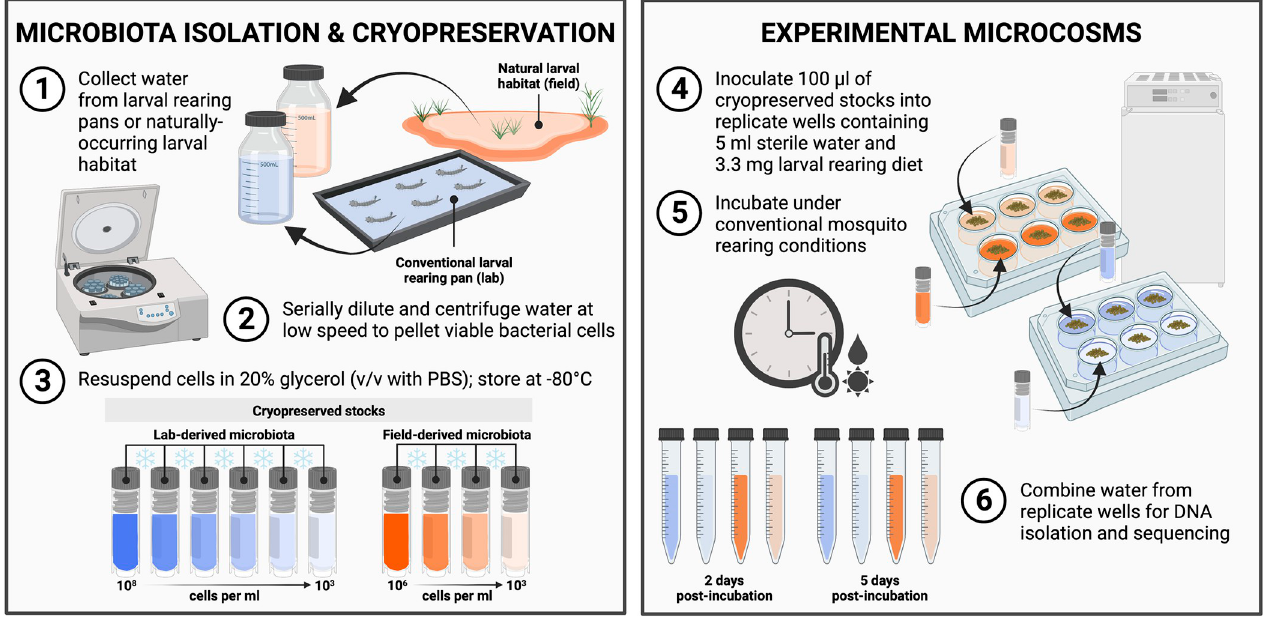
Fig 1. Overview of methodology used to isolate and cryopreserve microbiota and generate experimental microcosms. ( Left ) Isolation and cryopreservation of microbiota from conventional larval rearing pans of our laboratory colony of Ae . aegypti mosquitoes or a naturally occurring larval habitat in the field. Water from four replicate rearing pans containing larvae that had molted to the final (fourth) instar was collected from the lab, while four aliquots of water from the same larval habitat were collected from the field [1] prior to serial dilution and centrifugation at low speed to pellet any viable bacterial cells [2]. The resulting cell pellets were then resuspended in 20% glycerol (v/v with PBS) and stored at -80˚C to produce a total of 40 cryopreserved stocks at variable cell densities (~10 3 − 10 8 bacterial cells per ml) for use in downstream experiments [3]. Aliquots of non-cryopreserved fresh water from each rearing pan or habitat water sample in [1] were also immediately centrifuged at high speed prior to removal of any supernatant and storage of pellets at -20˚C for downstream DNA isolation and sequencing to characterize microbiota diversity. ( Right ) Generation of experimental microcosms colonized by standardized bacterial communities. Aliquots of 100 ul from each cryopreserved stock were inoculated into replicate wells of 6-well culture plates containing 5 ml of sterile water and 3.3 mg of a standard larval diet sterilized by gamma irradiation [4]. Replicate wells containing diet and 5 ml of non-cryopreserved fresh water from each rearing pan or habitat water sample in [1] served as unprocessed controls, while wells containing diet and sterile water only served as contamination controls. Culture plates were subsequently incubated under conventional mosquito rearing conditions [5] and water from replicate wells containing the same material was sampled 2- and 5-days post-incubation and combined [6] prior to centrifugation and storage as described above for downstream DNA isolation and sequencing. See “Methods” for more information. Created with BioRender.com.